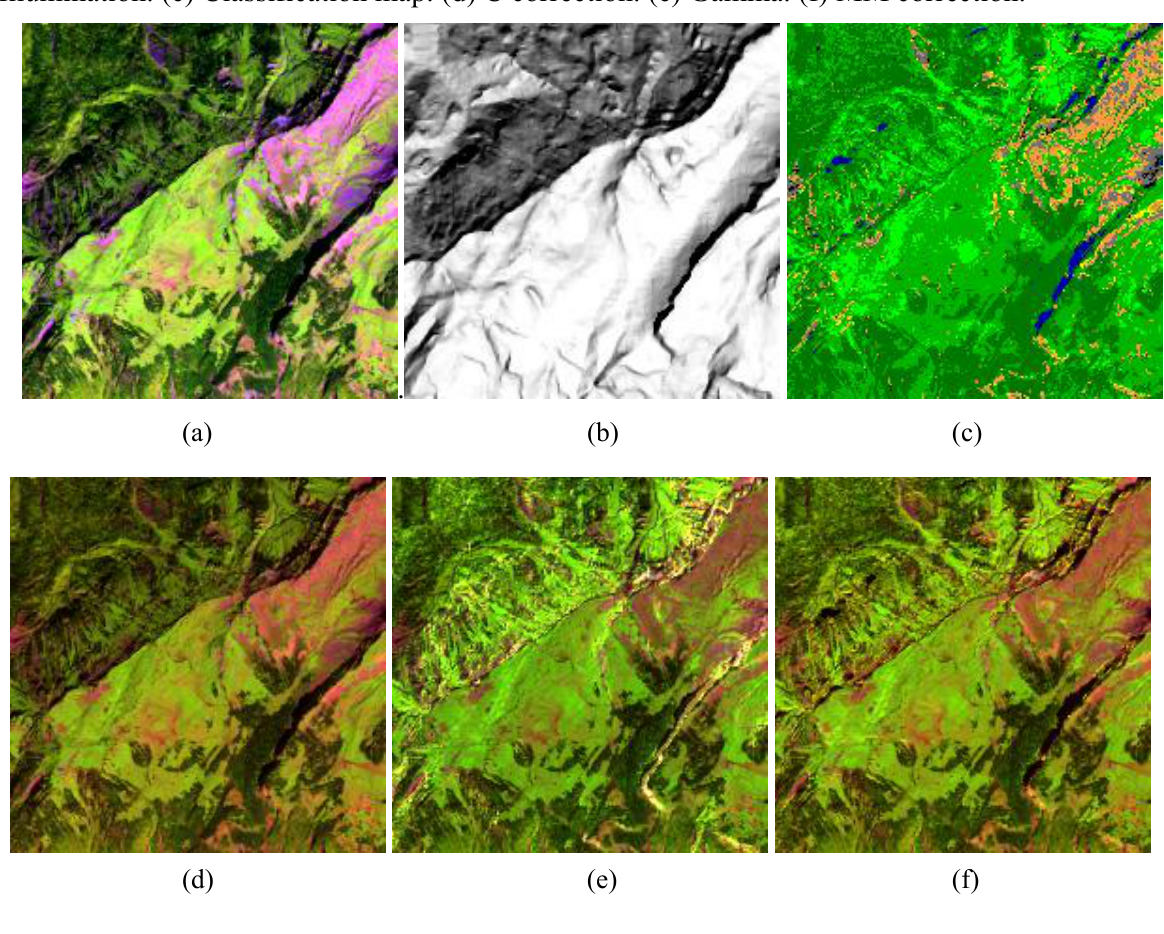
Figure 2. Sub-scene of (b), RGB = bands 4, 3, 2 (1650, 840, 660 nm). (a) Original. (b) Illumination. (c) Classification map. (d) C correction. (e) Gamma. (f) MM